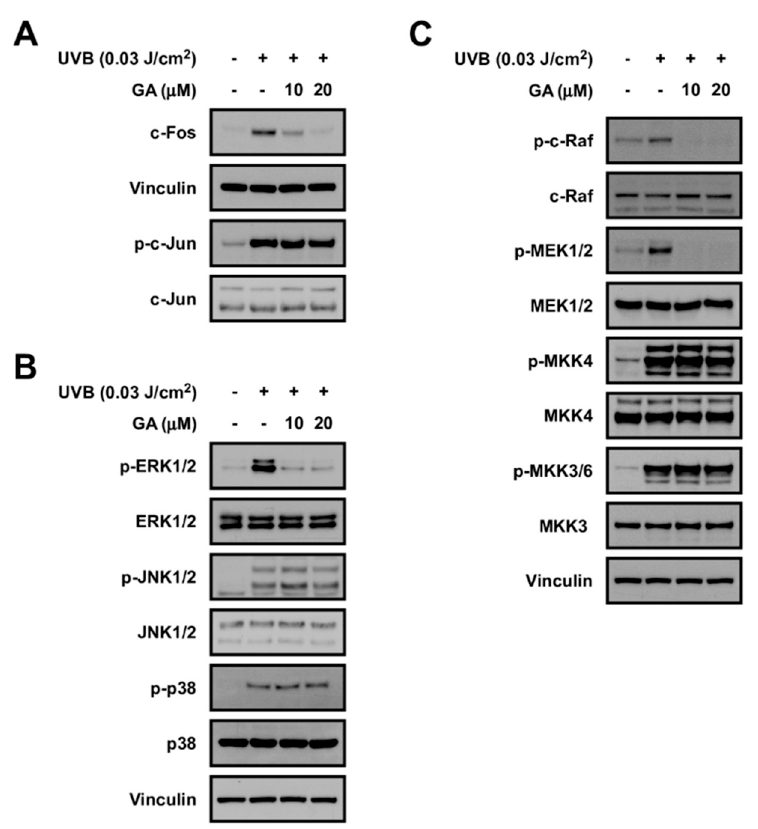
Figure 6. Effect of gallic acid (GA) on UVB − induced signaling pathways. ( A ) Protein expression of c − Fos, vinculin, p − c − Jun, and c − Jun were determined in human fibroblast cell lysates using the corresponding antibody. Vinculin was used as a loading control. ( B ) Effect of GA on MAPKs pathway in HDFs. Protein expression levels of phosphorylated and total ERK, JNK, p38, and vinculin were determined in cell lysates using the corresponding antibody by immunoblotting. Vinculin was used as a loading control. ( C ) Effect of GA on c − Raf and MAP2Ks pathway in HDFs. Protein expression levels of phosphorylated and total c − Raf, MEK1/2, MKK4, and MKK3, and vinculin were determined in cell lysates using the corresponding antibody by immunoblotting. Vinculin was used as a loading control.